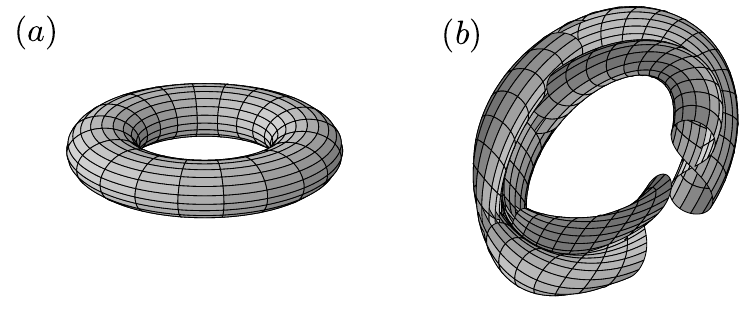
Figure 6: Two inequivalent classes of immersed torus up to regular homotopies: (a) standard, embedded, Arf-Kervaire 0, torus; (b) immersion, Arf-Kervaire 1, self-linked torus, which is similar to that of Fig. 5 with a